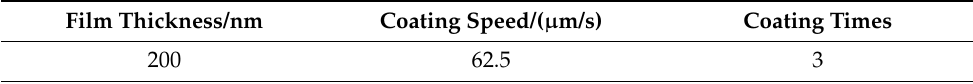
Figure 4. Film thickness–residual stress transformation curve. ( a ) All data; ( b ) Partial data magnification. Table 2. Optimum coating process